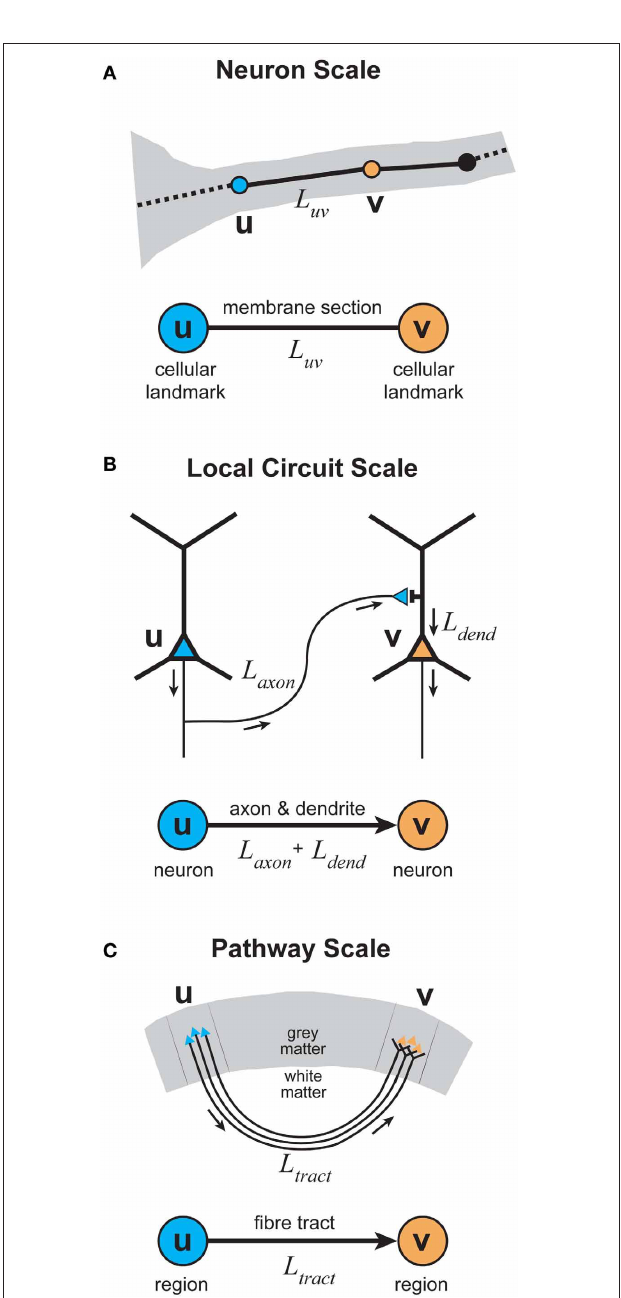
FIGURE 3 | Elementary graphical representations of cortical organization at different spatial scales. (A) Neuron scale . Each vertex represents the location of a cellular landmark obtained from the 3D reconstruction of individual axonal or dendritic arbors (e.g., location of the presynaptic terminal boutons) with an undirected edge representing the section of membrane linking these vertices either by the actual path length or the direct distance between a vertex pair. (B) Local Circuit scale . Each vertex represents the somatic location of a single neuron with a directed (or undirected) edge representing the sum of the axonal and dendritic lengths connecting a pair of neuronal somata. (C) Pathway scale. Each vertex represents a distinct cortical brain region in grey matter with a directed (or undirected) edge representing the axonal fiber tract connecting a pair of cortical regions, where its length describes the actual path or direct distance of its course within white